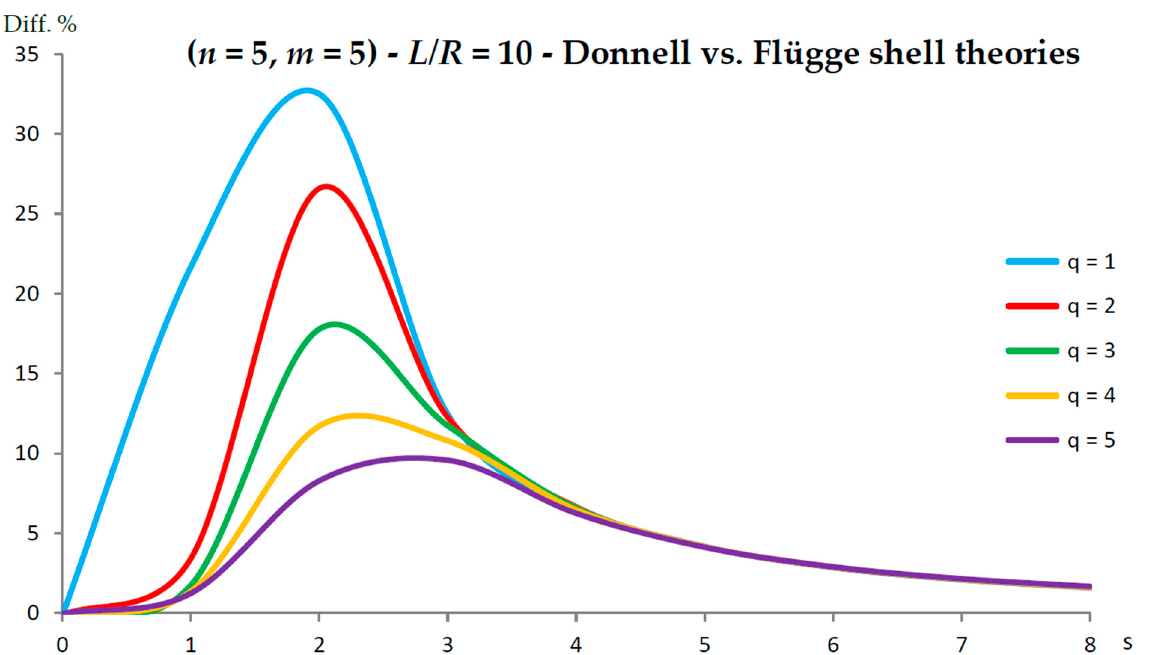
Figure 2. Percentage differences between the radial natural frequencies obtained via Donnell and Flügge shell theories (Flügge as the reference). Anisotropic elastic shell model. Simply supported SWCNT of Table 1 with chirality indices ( n = 5, m = 5 ) and aspect ratio L / R = 10. Number of longitudinal half-waves q . Number of circumferential waves s